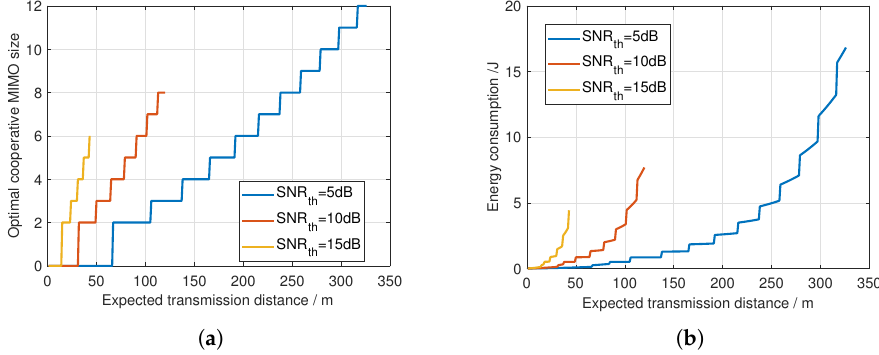
Figure 5. The results of the CMSO algorithm. ( a ) The optimal number of cooperative MIMO members at different expected transmission distances. ( b ) The energy consumption per node at different expected transmission